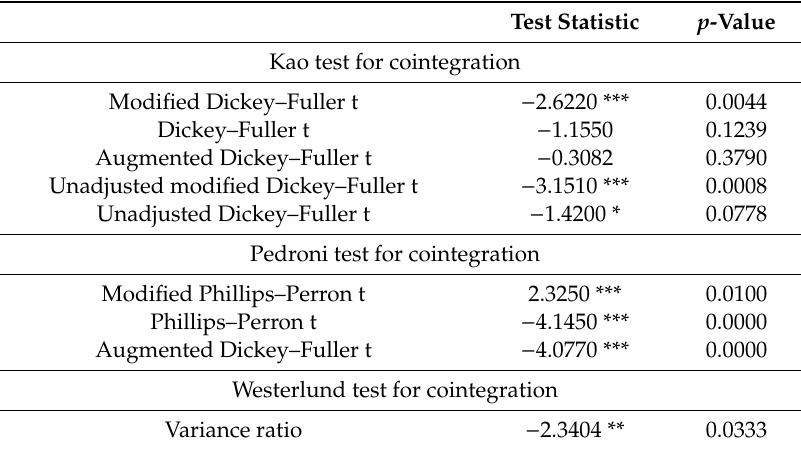
Table 5. Cointegration tests for model 1 (Equation